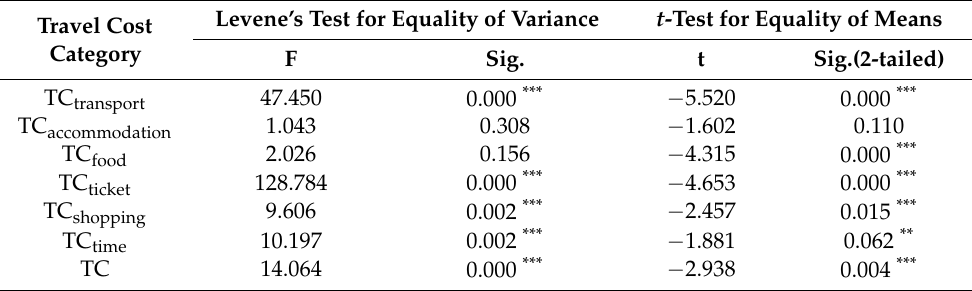
Table 3. Independent-samples t -test of various travel costs for the two groups 1 .